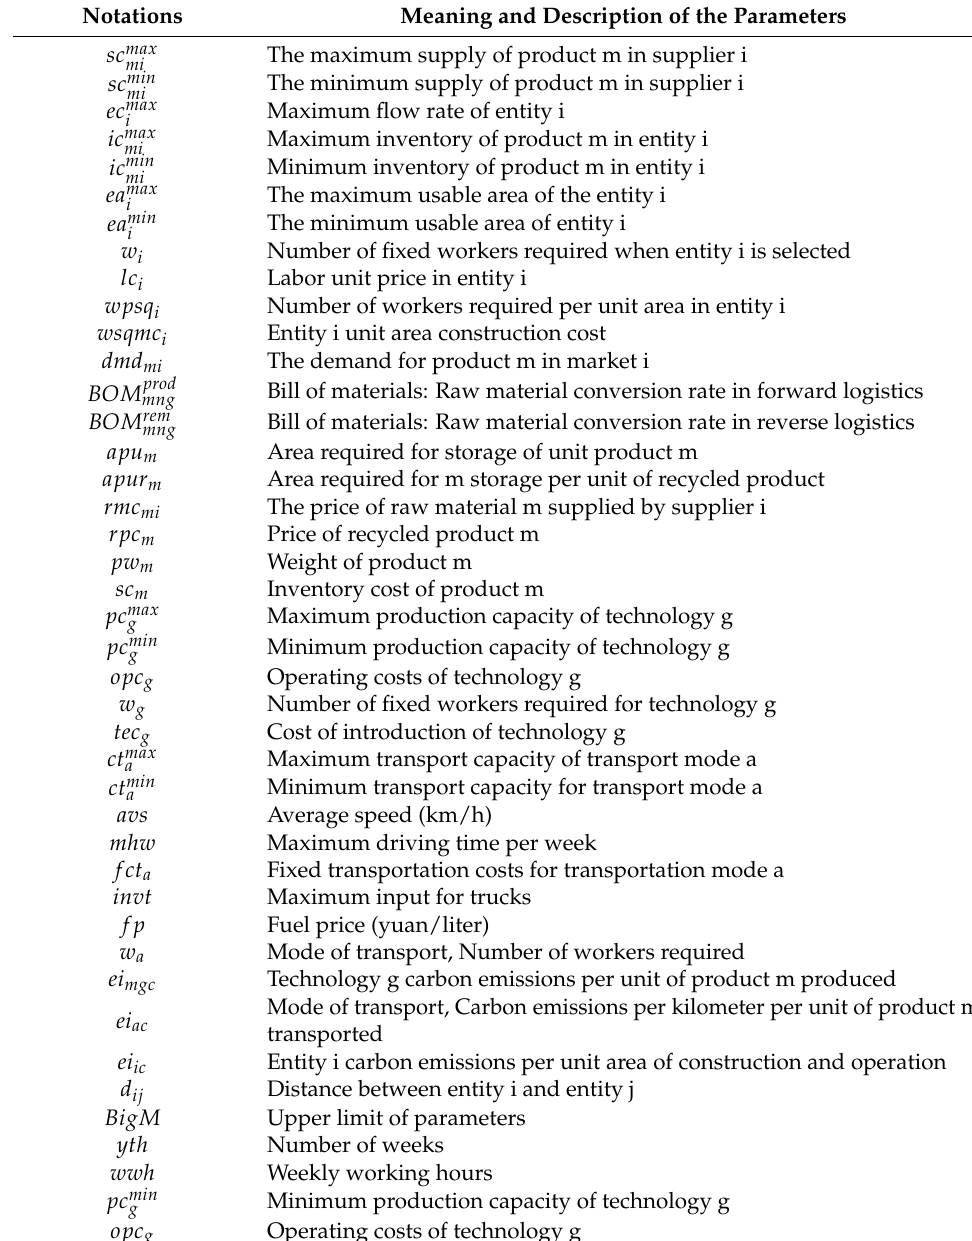
Table 2. Parameters of mathematical